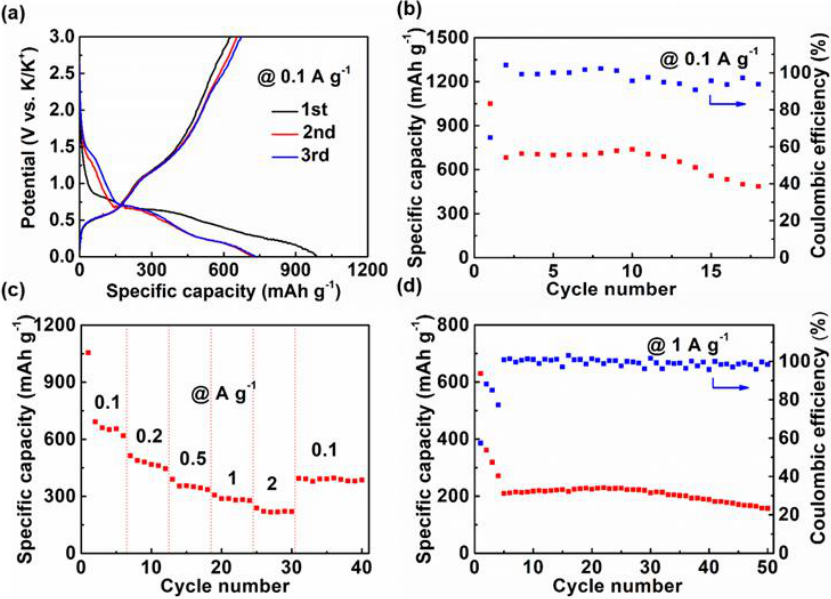
Figure 4. Electrochemical performances of Sb 2 S 3 @PPy as an anode in potassium ion batteries (KIBs). ( a ) Galvanostatic charge and discharge curves at 0.1 A g − 1 for the first three cycles. ( b ) Cycling stability and corresponding Coulombic efficiency at 0.1 A g − 1 . ( c ) Rate capability from 0.1 to 2 A g − 1 . ( d ) Cycling stability and corresponding Coulombic efficiency at 1 A g − 1 .